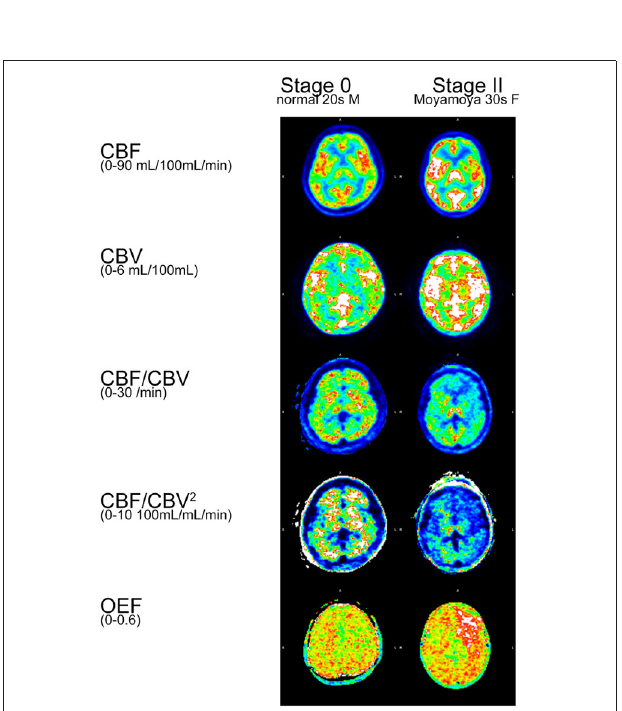
FIGURE 4 | Example of 15 O PET